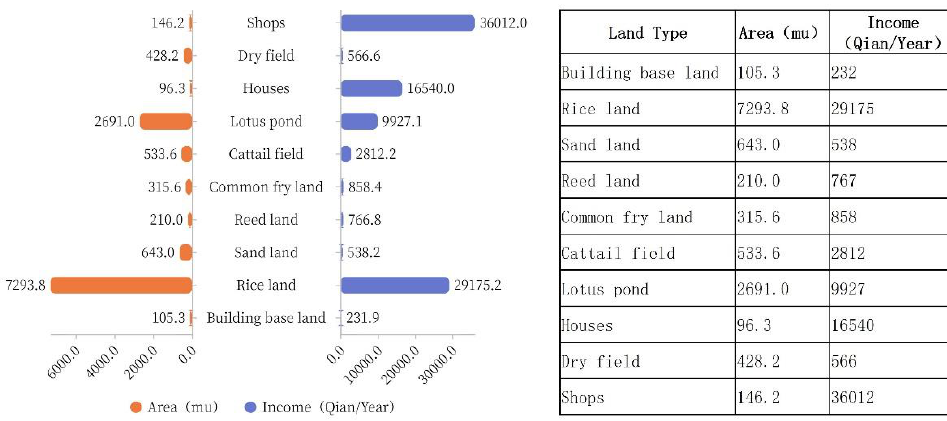
Figure 17. Two-way comparative chart of land scale and levied land income.